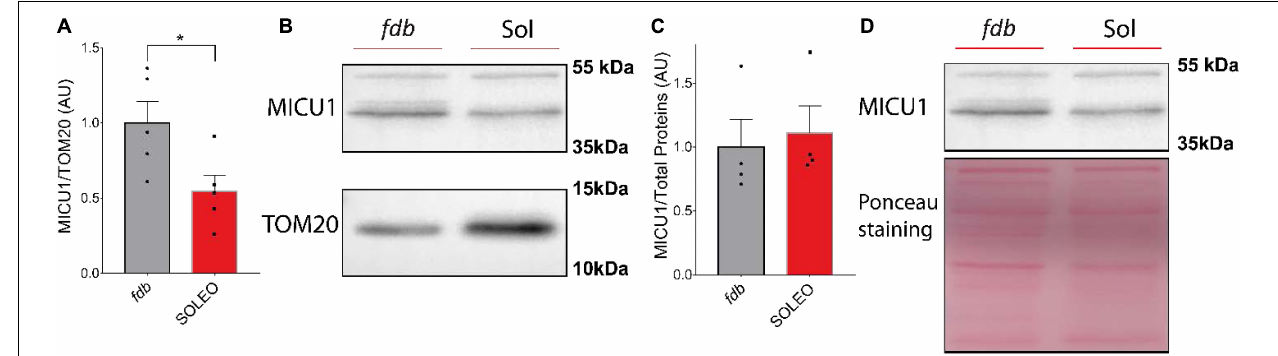
FIGURE 6 | Mitochondria from Flexor Digitorium Brevis ( fdb ) muscle presented a higher content of MICU1 protein than mitochondria from soleus (sol) muscle. Representative Western Blot and quantification show the levels of the MICU1 protein in homogenates of fdb and sol, normalized by a mitochondrial marker ( n = 5) (A,B) and total protein ( n = 4) (C,D) . For (C) using the Mann-Whitney test was applied. Values are presented as mean ± SEM. * p < 0.05; ** p < 0.01; *** p <